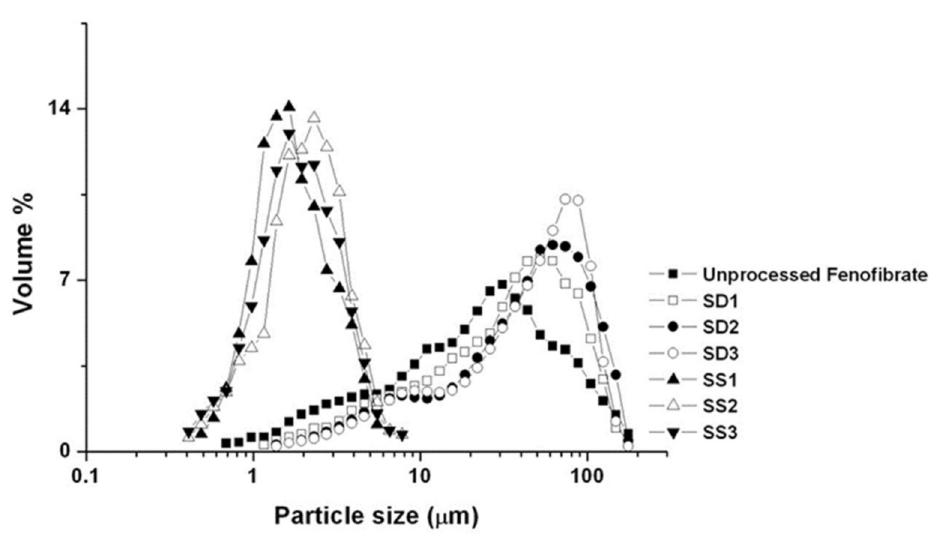
Figure 4. Particle size distribution of the fenofibrate microparticles produced by two different particle formation processes (SD and SA-SD). Table 2. The results of particle size, zeta potential, and contact angle analyses (mean ± S.D., n = 3).